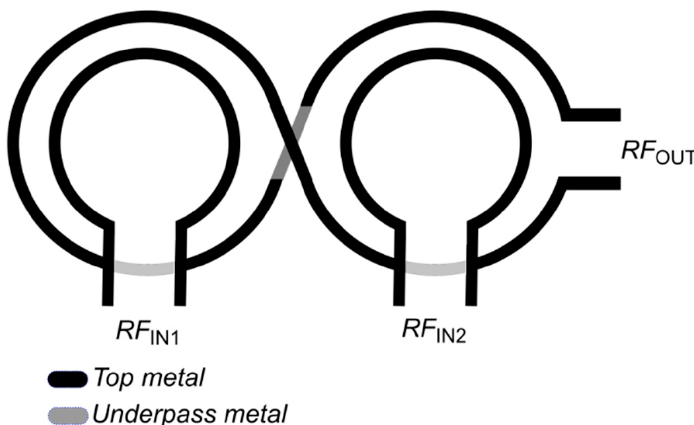
Figure 8. Example of an SCT for PA voltage combining.